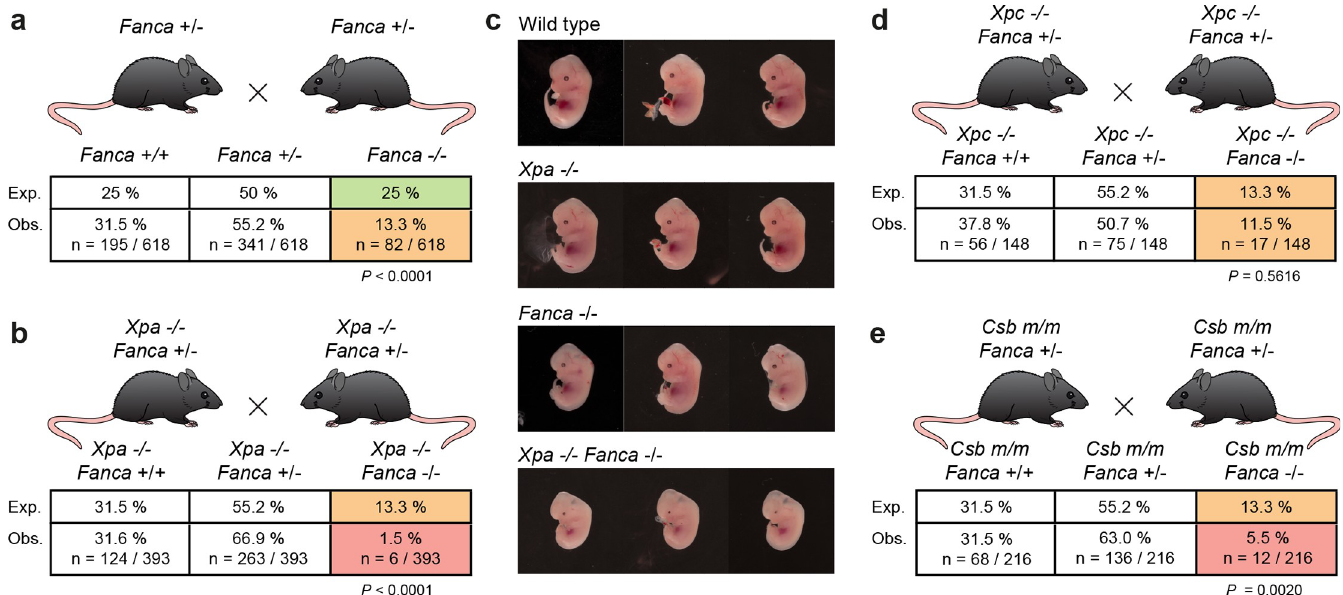
Fig 4. TC-NER and the FA pathway cooperate to ensure normal mouse development. a) Fanca +/- crosses in a C57BL/6 background showing that Fanca -/- mice are genotyped at sub-Mendelian ratios 2–3 weeks after birth (13.3% instead of the expected 25%, P : Fisher’s exact test compared to expected numbers. b) Xpa -/- Fanca +/- crosses for the generation of double mutant mice in a C57BL/6 background c) Examination of E13.5 embryos generated from Fanca +/- or Xpa -/- Fanca +/- crosses in a C57BL/6 background. d) Xpc -/- Fanca +/- crosses for the generation of double mutant mice in a C57BL/6 background. e) Csb m/m Fanca +/- crosses for the generation of double mutant mice in a C57BL/6 background. In a, b, d, and e, pups were genotyped 2–3 weeks after birth. In b, d, and e P : Fisher’s exact test, compared to numbers from Fanca +/-